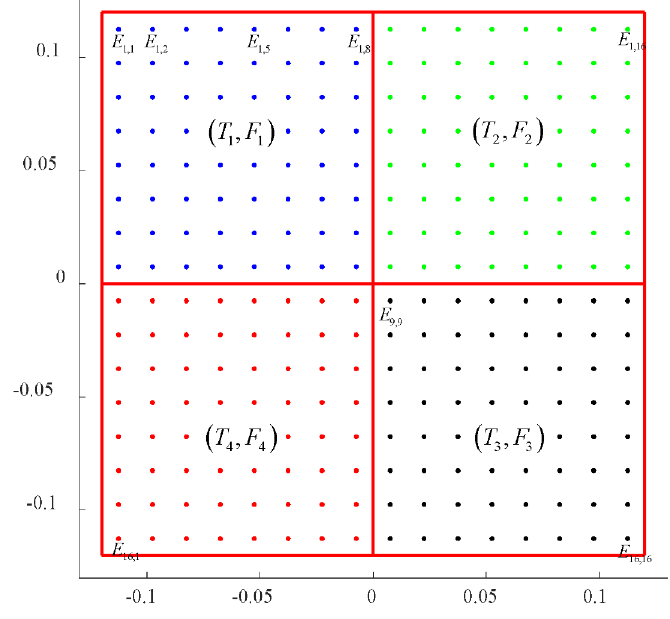
Figure 8. The elements ’